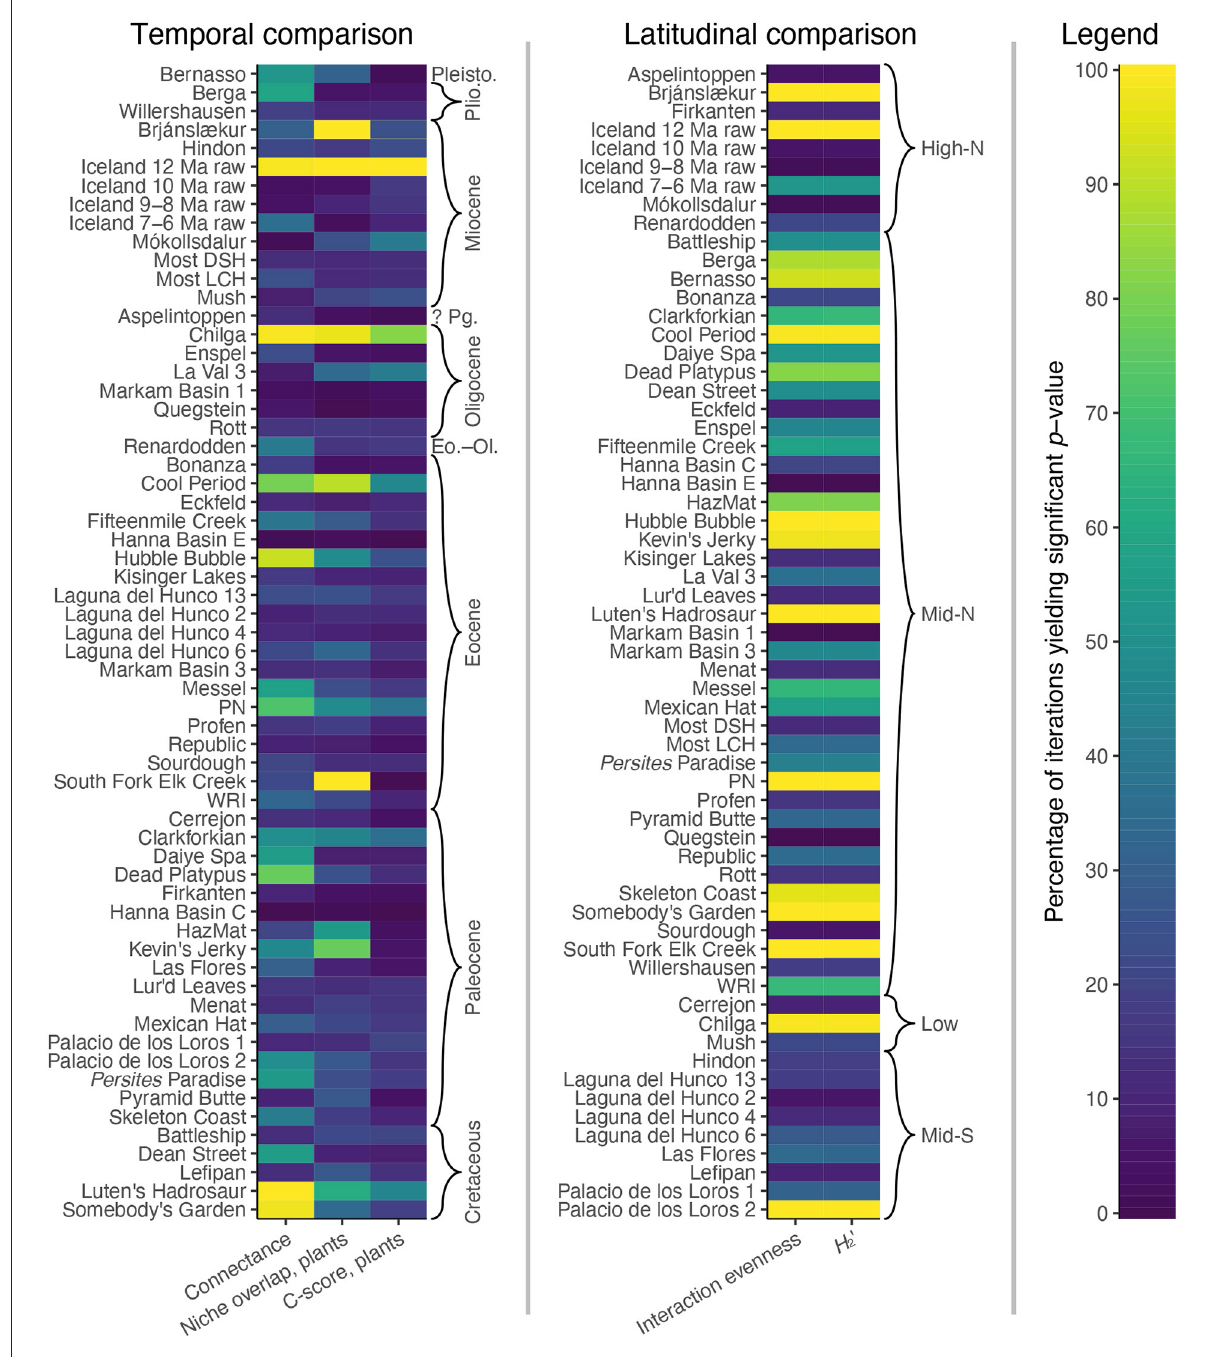
FIGURE11 The results of null model comparisons for the bipartite network metrics that underlie (Currano et al., 2021)’s conclusions about trends through time and across latitudes.